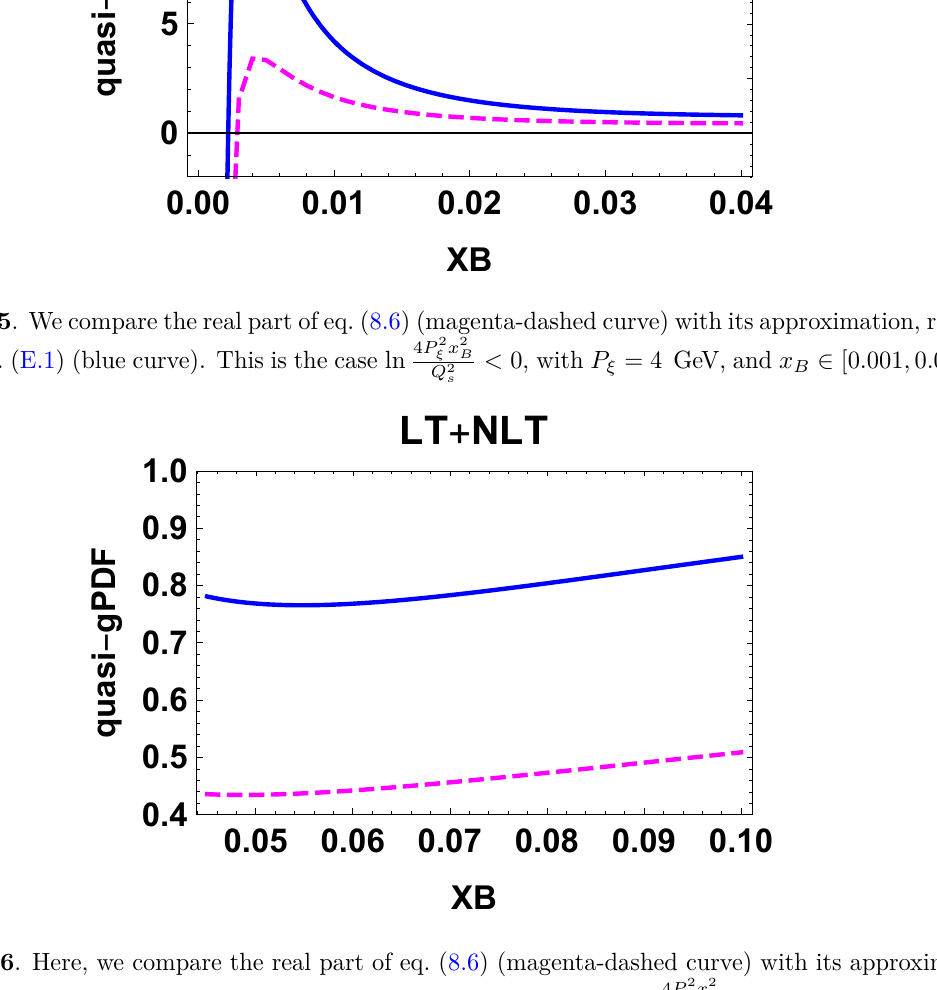
2 2 B ξ x > 0 , with P ξ = 4 GeV, Q 2 s